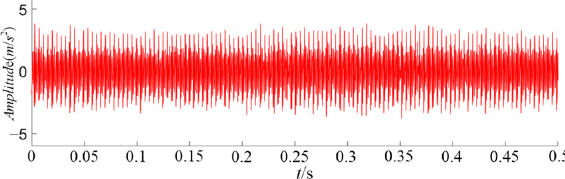
Figure 1. Time domain waveform of vibration signal of main pump in blade abnormal state.